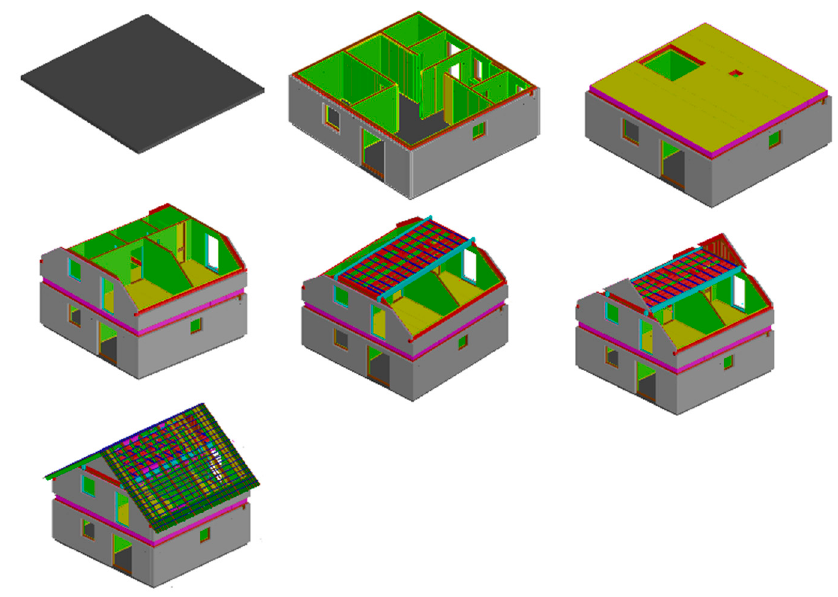
Figure 1. Assembly process of an object in prefabricated technology.